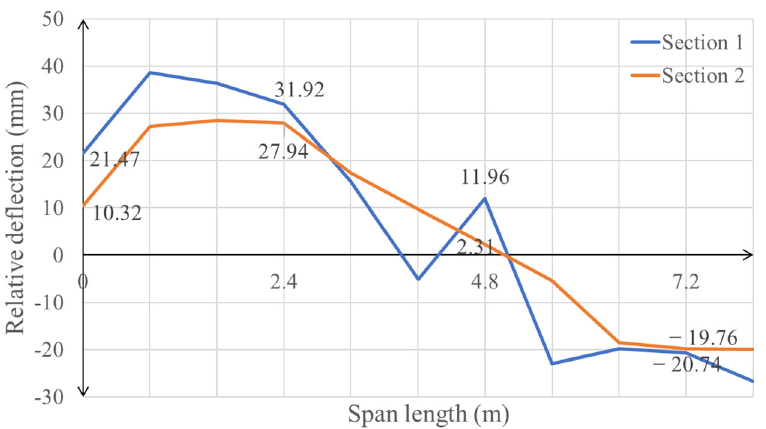
Figure 18. Relative deflection graph of the two sections.